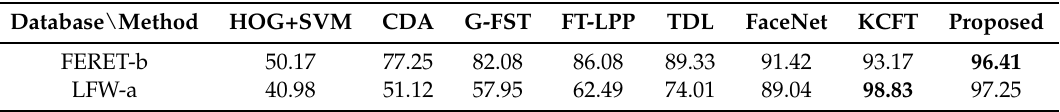
Table 2. Rank-1 identification rates (%) of different methods on FERET-b and LFW-a. The best result on each database is shown in